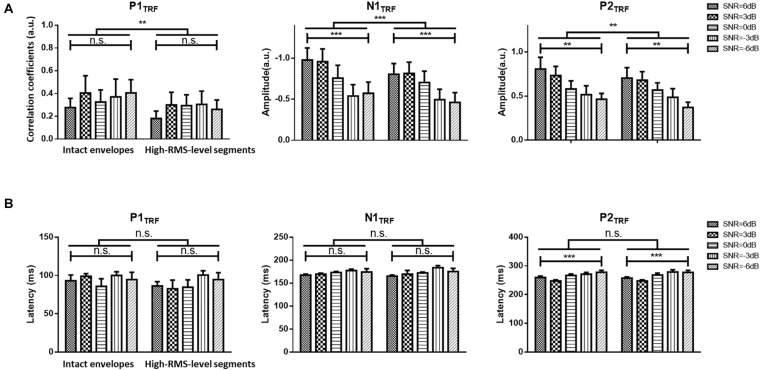
(A) Statistical results (mean ± standard deviation) for TRF values with intact and high-RMS-level-only envelopes at three typical deflections across subjects. (B) Statistical results (mean ± standard deviation) for TRF latencies with intact and high-RMS-level-only envelopes at three typical deflections across subjects in five SNR conditions. ***P < 0.001, **P < 0.01 (prediction difference). n.s., no significant difference (analysis of variance). SNR, signal-to-noise ratio.